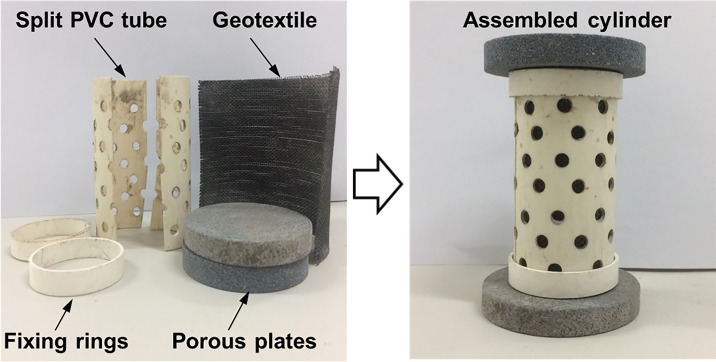
Cylindrical mold for MICP treated specimens.